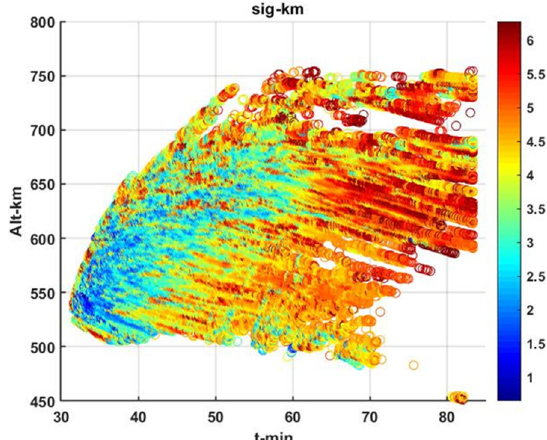
Fig. 2 EPB altitude-dependent turbulent-strength parameter evolution